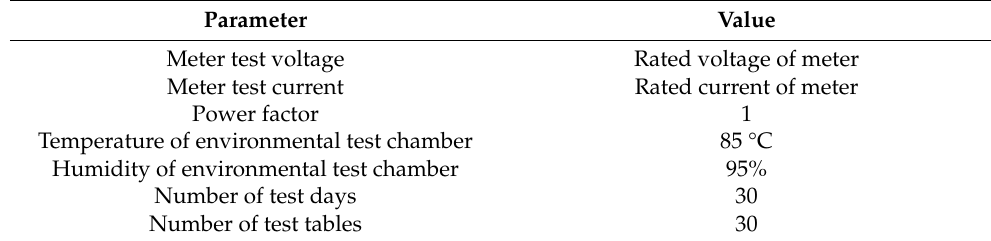
Table 1. Electrical life test parameters.